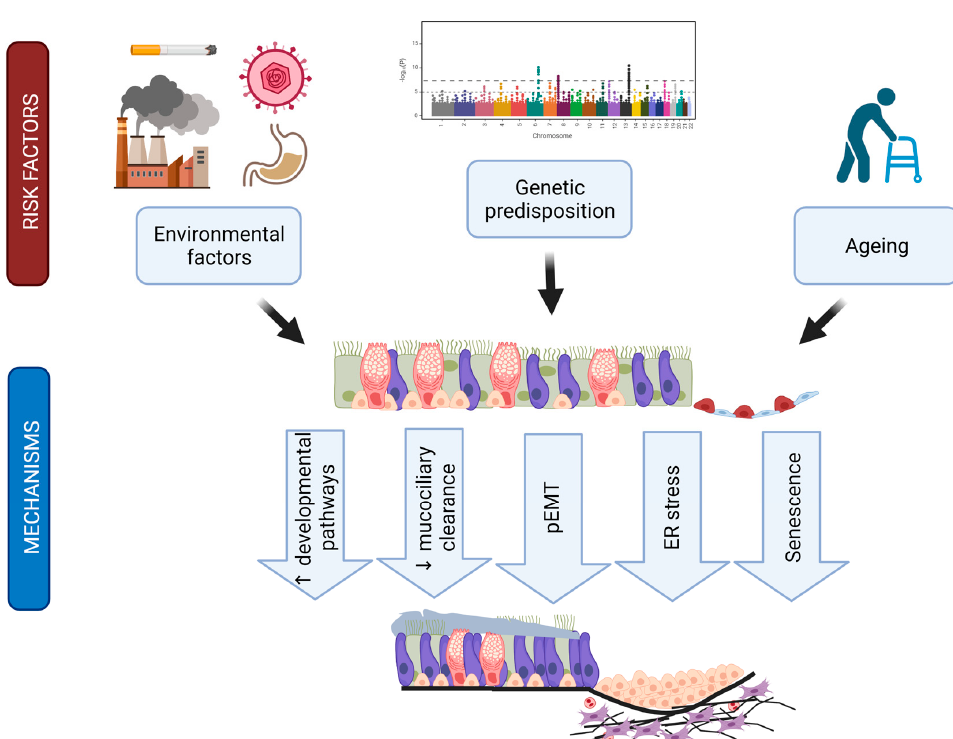
Figure 7. Hypothetical contributions of the airway epithelium to IPF pathogenesis. Summarizing scheme linking established environmental and genetic risk factors via the bronchial and bronchiolar epithelium to IPF-specific disease mechanisms and outcomes like bronchiolization and interstitial scarring. Figure was created with